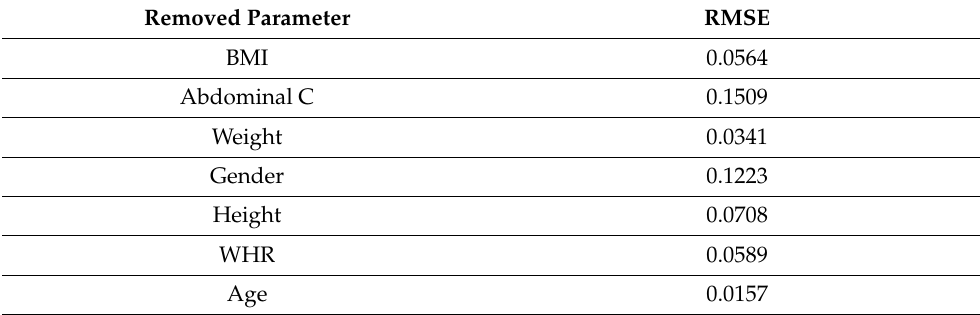
Table 3. Coefficients of correlation matrix between the